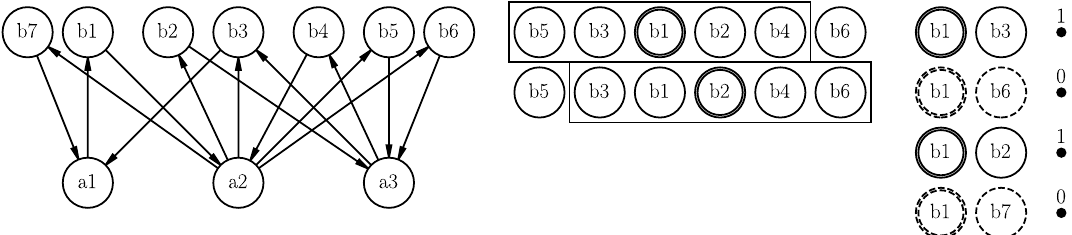
Figure 10. (Left) the example network with b1-b7 as business process nodes and a1-a3 as financial account nodes, we sample a path from this network with DeepWalk or finWalk. Middle) one sampled path with a sliding window at the first and the second position. The context box indicates the full window with b 1 and b 2 as target nodes. Right) generated training pairs from the first window for the prediction model, solid lines are examples from the sampled path (positive items) and dashed pairs are negative